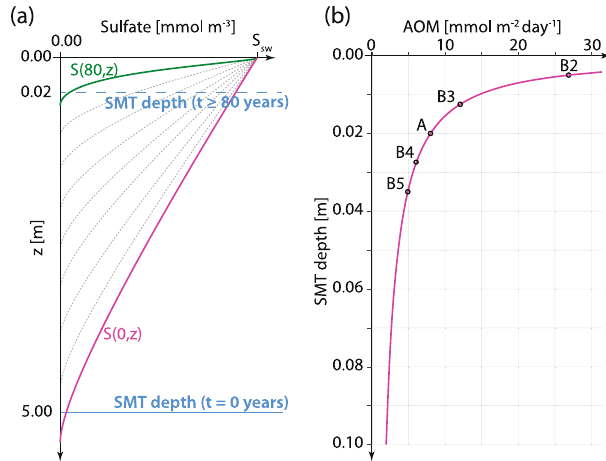
Fig. 2 Vertical sulfate concentration gradient and the corresponding anaerobic oxidation of methane (AOM) capacity. a Schematic view (not to scale) of the transient response of the vertical sulfate pro fi le to a sudden increase in CH 4 fl ux from below, with inspiration from 24 . S(t,z) is sulfate concentration, t is time in years, and z is depth below sea fl oor in meters. S sw is the fi xed bottom water sulfate concentration and SMT is the sulfate- methane transition at the base of sulfate-reduction zone. b The Egger relation 25 describes the depth-integrated AOM capacity as a function of SMT depth. The SMT min for Cases A and B2-B5 are shown as black circles (Case B1 is outside the plotted